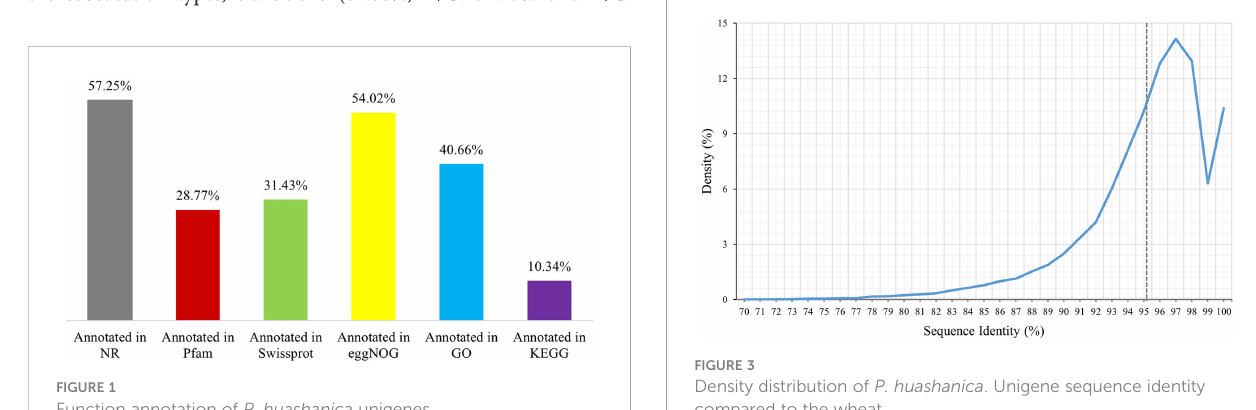
FIGURE 3 Density distribution of P. huashanica . Unigene sequence identity compared to the